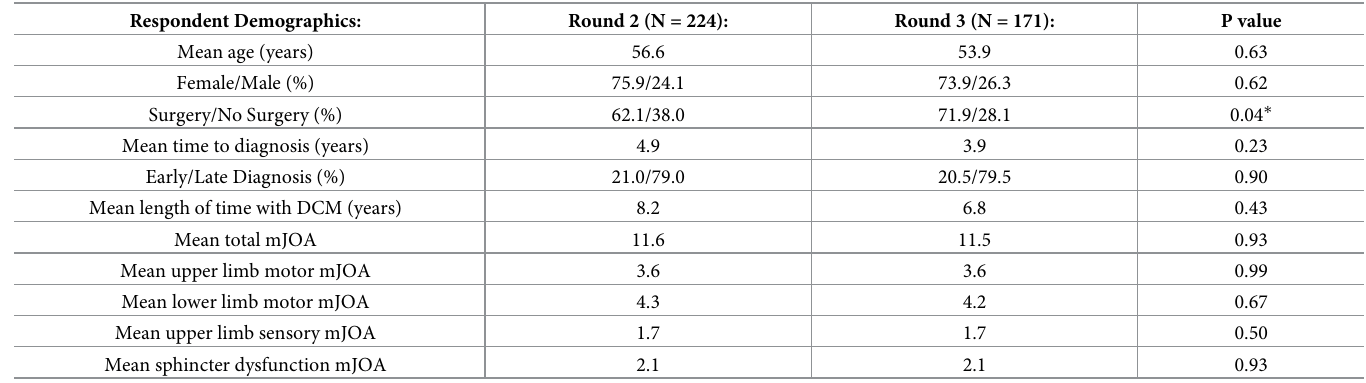
Table 3. Comparison of demographics of survey respondents in round 2 and round 3.